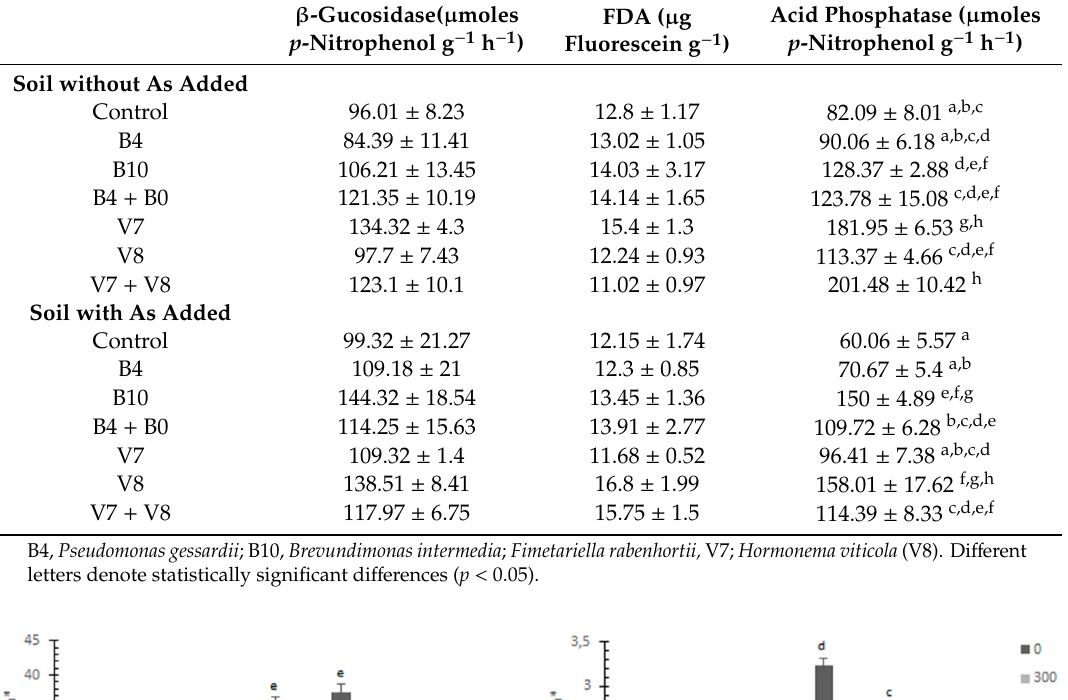
Table 4. β -glucosidase, acid phosphatase and hydrolysis of fluorescein diacetate activity (FDA) in rhizospheric soil of T. aestivum without the addition of As and the addition of 300 mg · Kg − 1 of As.